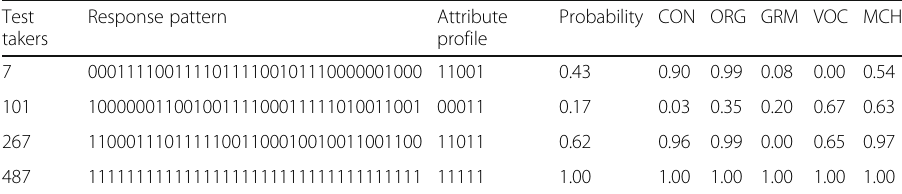
Table 8 Skill-mastery probabilities Test Response pattern Attribute takers